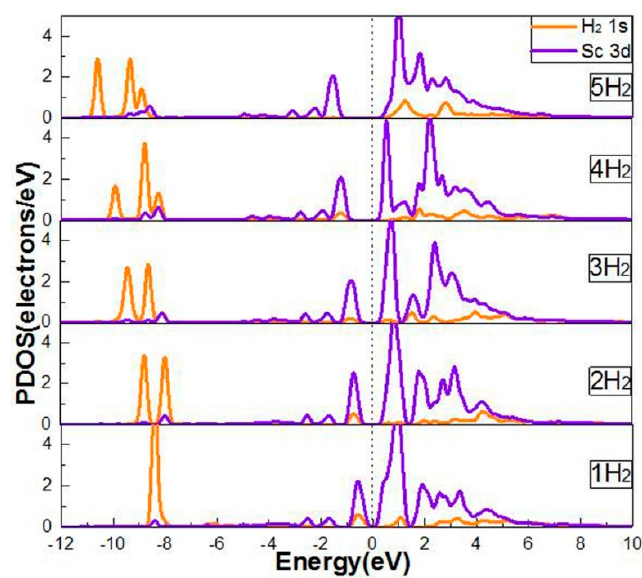
Figure 5. PDOS of Sc-decorated B-PG with one to five H 2 molecules adsorbed.